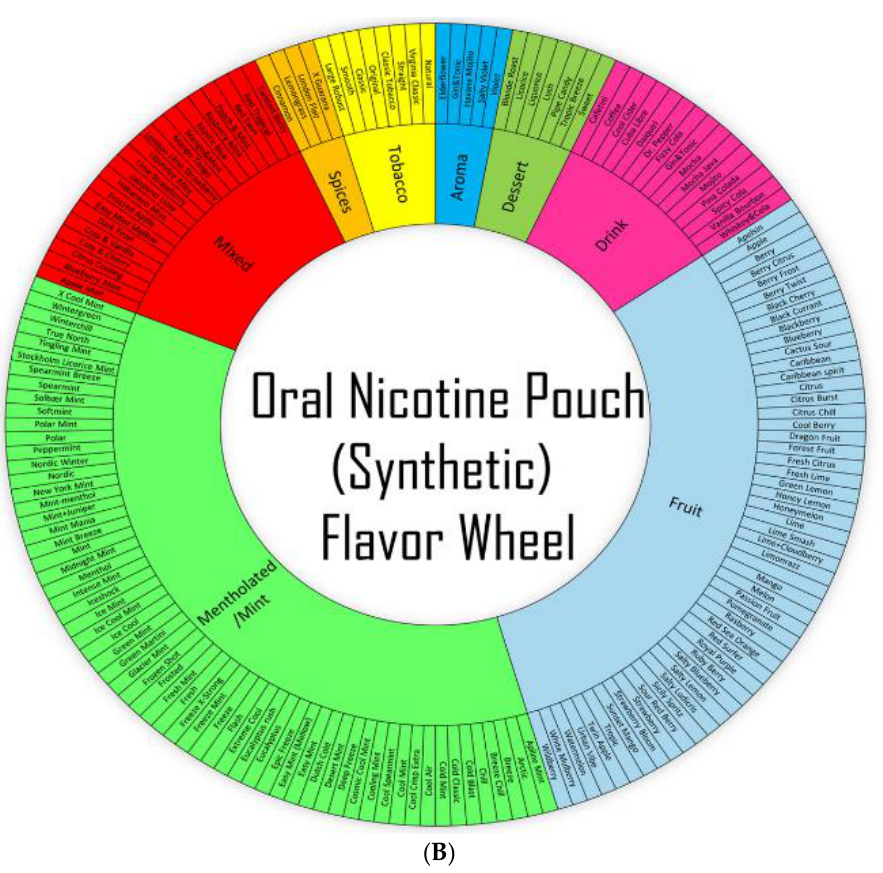
Figure 1. Wheel-based Classification/Categorization of Natural/Synthetic Oral Nicotine Pouches (ONPs)/products commonly sold in the U.S . (A) Flavor wheel for Natural/Snus Oral Nicotine Pouch (B) Flavor wheel for Synthetic oral Nicotine Pouch. The nicotine concentration of all smoke-free nicotine-based pouches ranges from 3 mg to 8 mg per pouch; mint/menthol and fruit are two of the most widely sold flavors in the U.S. The flavors of each pouch product in the diagram are color-coded by flavor category, Bright green Color represents ONPs of mint/menthol flavors, Light blue for fruit flavors, Red color mixed flavors, Pink color ONPs available in drink flavors, Yellow color for Tobacco flavors ONPs, parrot green color ONPs available in dessert flavors, Sky blue ONPs in aroma flavors and Orange represents ONPs available in flavor of spices. The inner wheel represents the most common flavors, and the outer wheel represents specific flavors.